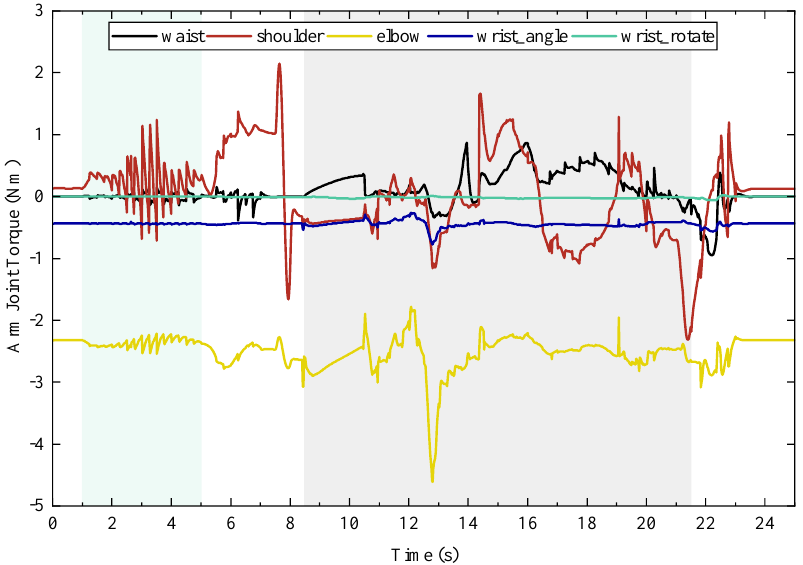
Figure 12. The time evolution of the commanded torques of arm joints generated by the whole-body controller. The gray area indicates the time duration of manipulating the